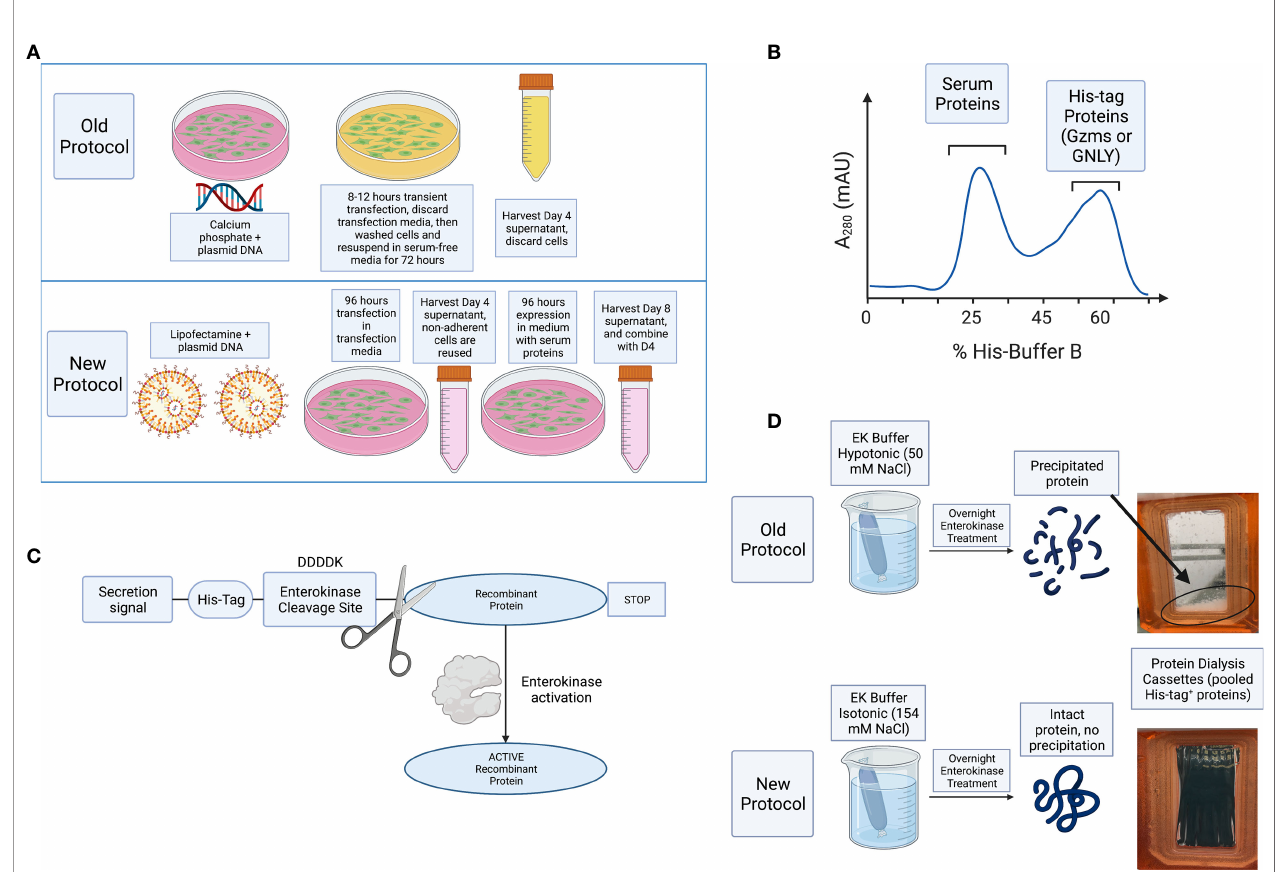
FIGURE 1 | Schematic representation of improvements and summary of steps necessary for puri fi cation of Gzms and GNLY. (A) Comparison of the old vs new protocols, HEK293T cells are transiently transfected with lipofectamine 3000 instead of calcium phosphate. Cells are then incubated for 96 hours in transfection medium without the need for washing away the calcium phosphate transfection solution with PBS, and subsequent resuspension in serum-free medium. Secreted protein is harvested at D4, cells are resuspended in fresh medium, and harvested again at D8. (B) Secreted proteins are then puri fi ed using Ni-IMAC puri fi cation by isolation of His-tag on recombinant proteins and removal of bulk serum proteins. (C) Scheme showing that following EK activation, the His-tag is removed from the fi nal recombinant protein. (D) EK cleavage under isotonic solution activates fi nal protein and prevents sample loss, while hypotonic solution leads to protein precipitation and loss of sample recovery. Created with